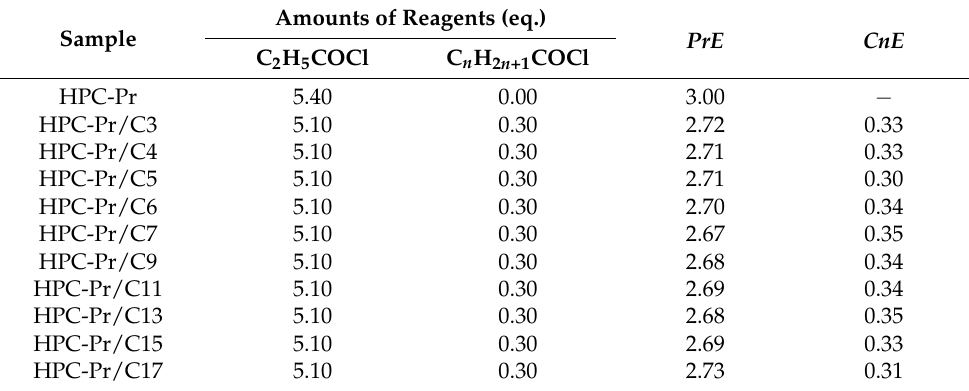
Table 1. Feed amounts of alkanoyl chlorides used in the syntheses of HPC-Pr/C n , and the number of the hydroxy groups substituted by C 2 H 5 COCl and C n H 2 n +1 COCl per anhydroglucose unit, denoted as PrE or CnE , respectively, determined by 1 H-NMR spectra. The amounts of reagents are expressed in the unit of equivalents relative to the number of anhydroglucose units in 2.00 g of HPC. Amounts of Reagents (eq.) Sample